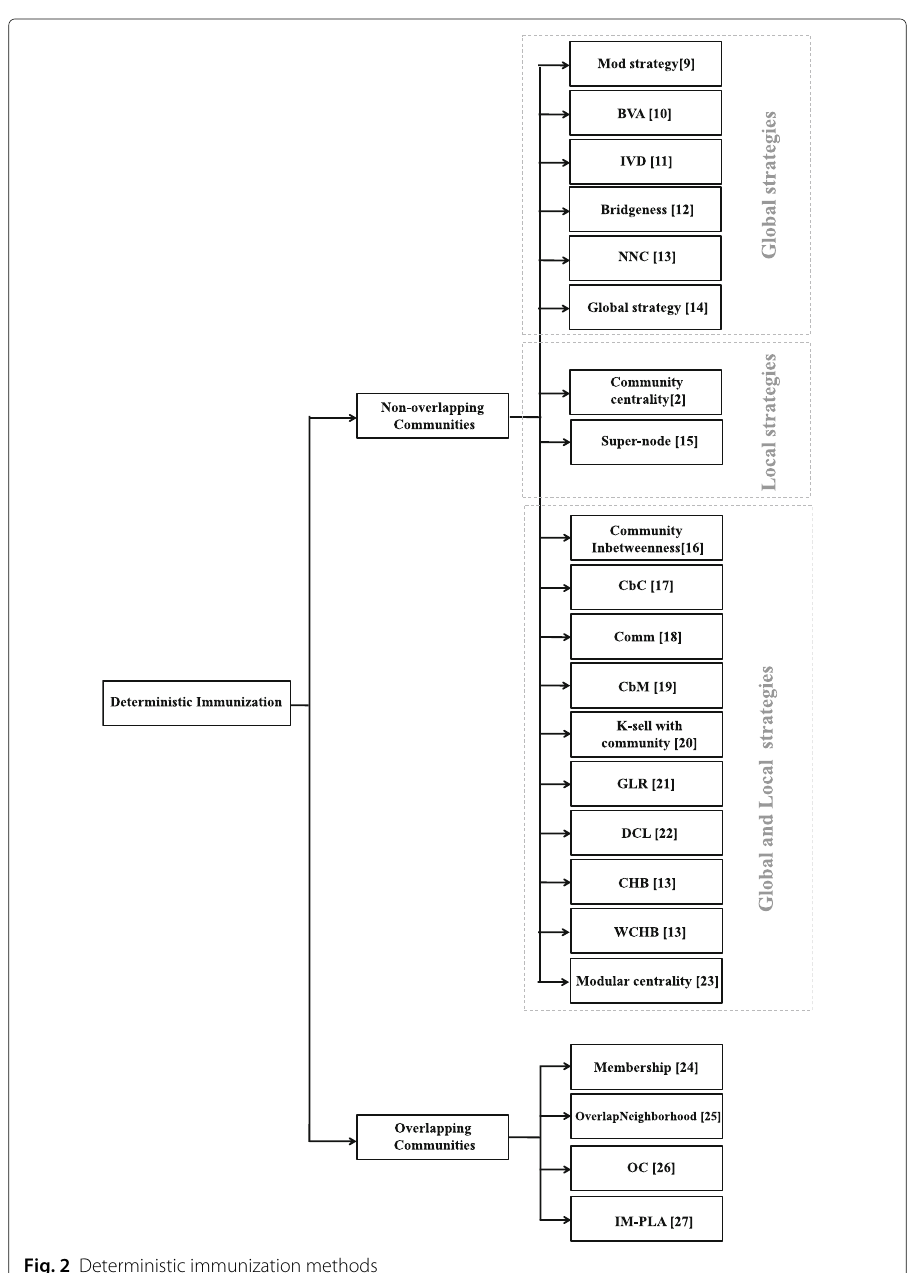
Fig. 2 Deterministic immunization methods